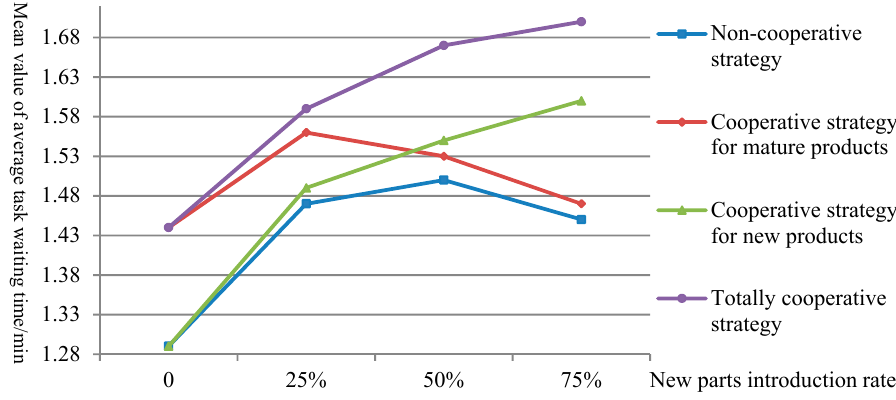
Figure 7. Mean values of average task waiting time under different conditions.